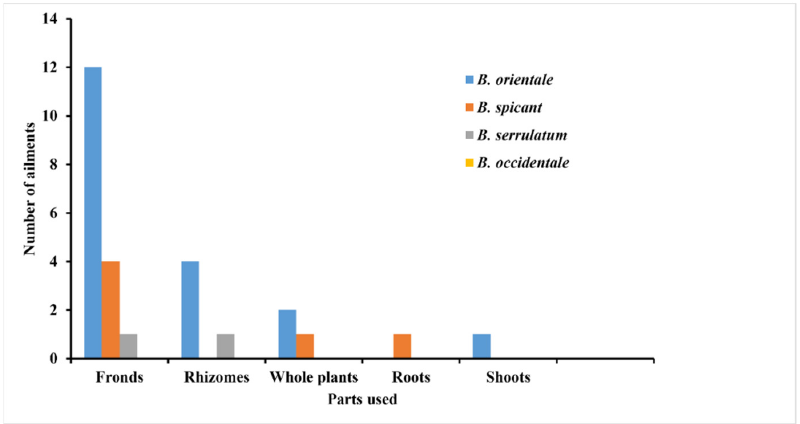
Figure 4. Application of Blechnum species against different